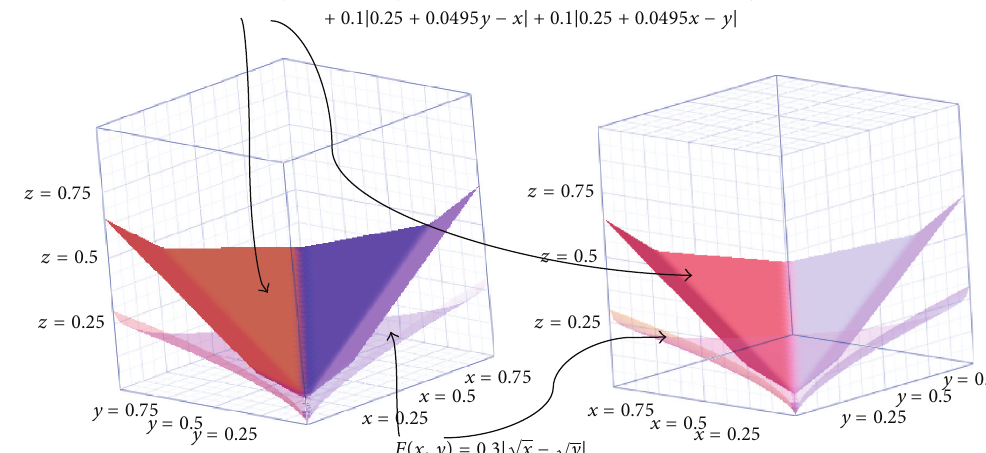
Figure 2: Two surfaces 𝐹(𝑥,𝑦) ≤ 𝐺(𝑥, 𝑦) in the unit cube.